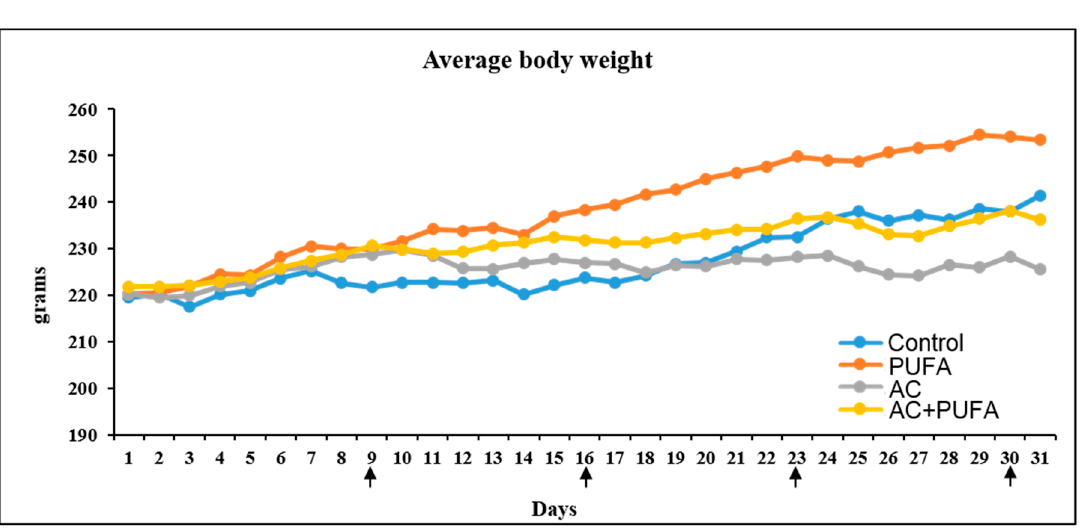
Figure 1. Effects of daily omega-3 polyunsaturated fatty acid (PUFA) supplementation and 4 weekly AC treatment on daily body weights. Vertical arrows indicate days of injections with water control or adriamycin and cyclophosphamide in combination (AC).